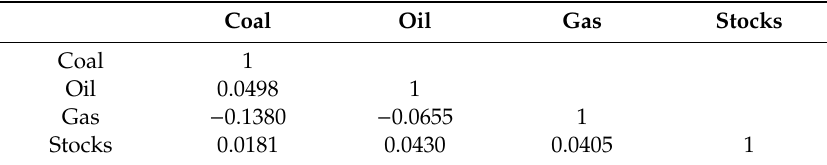
Table 18. Correlations for Sweden.